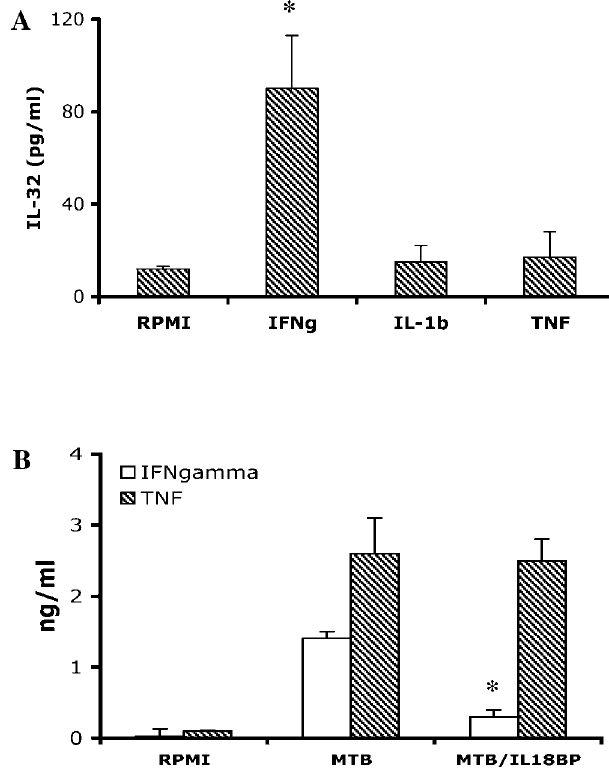
Figure 5. IFN c Is a Stimulus of IL-32 Production (A) PBMCs isolated from five volunteers were stimulated with IFN c , IL-1 b , or TNF a (all at a concentration of 10 ng/ml). IL-32 concentrations were measured by ECL 24 h later in cells lysed with Triton X-100. (B) PBMCs were stimulated for 24 h with RPMI, M. tuberculosis (MTB), or M. tuberculosis in combination with 10 l g/ml IL-18BP. IFN c and TNF a concentrations were measured 24 h later. Data are presented as means 6 SEM ( n ¼ 5); *, p , 0.05. DOI: